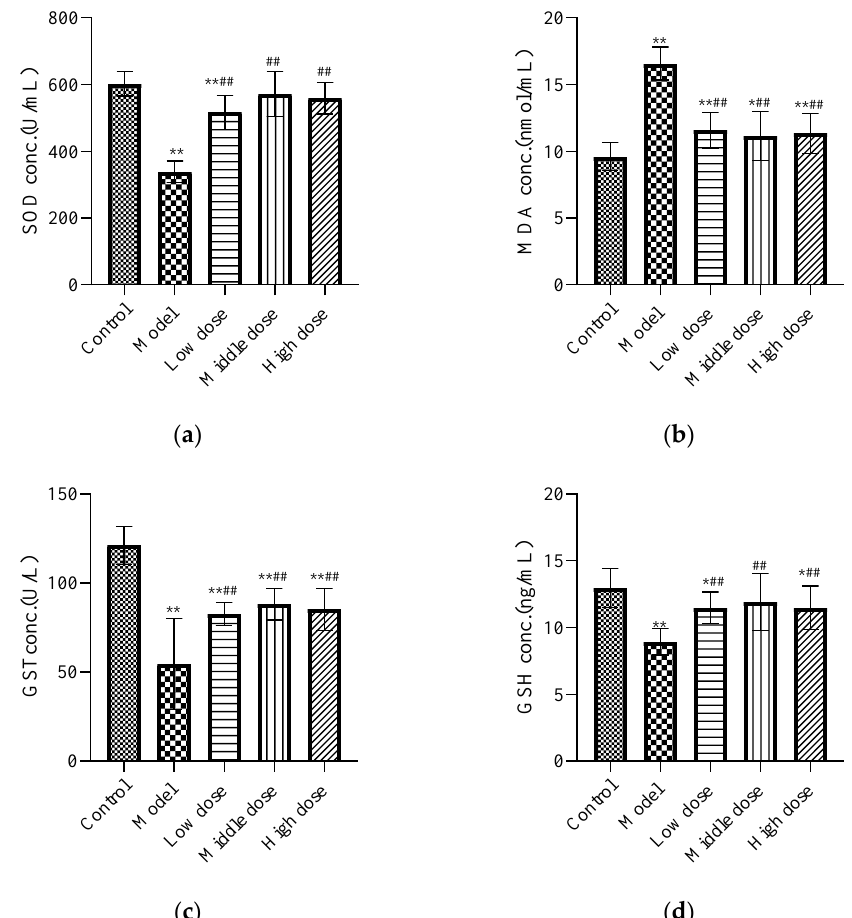
Figure 3. Effects of LBP on oxidative stress markers. The results are expressed as the mean ± SD, n = 10. * Statistically significant compared to control group, * p < 0.05, ** p < 0.01. # Statistically significant compared to model group, # p < 0.05, ## p < 0.01. ( a ) Expression of superoxide dismutase (SOD); ( b ) Expression of malondialdehyde (MDA); ( c ) Expression of glutathione S-transferase (GST); ( d ) Expression of glutathione (GSH).